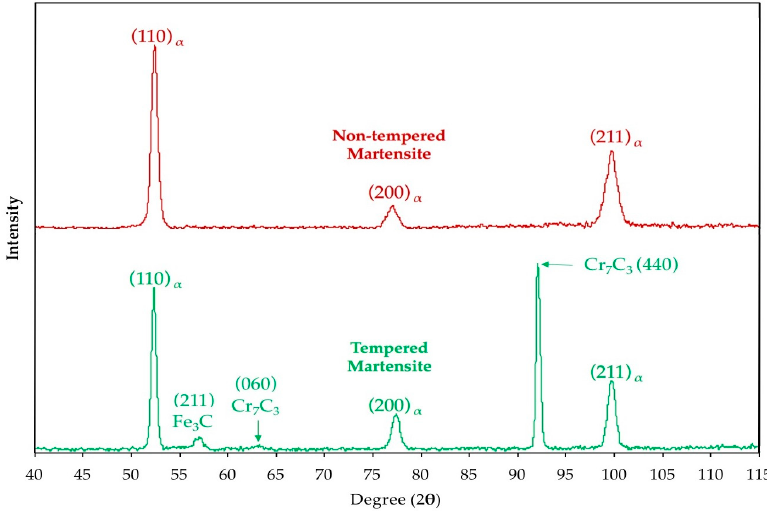
Figure 8. XRD spectra of martensite and non-isothermal tempered martensite at heating rate of 5 °C/min.